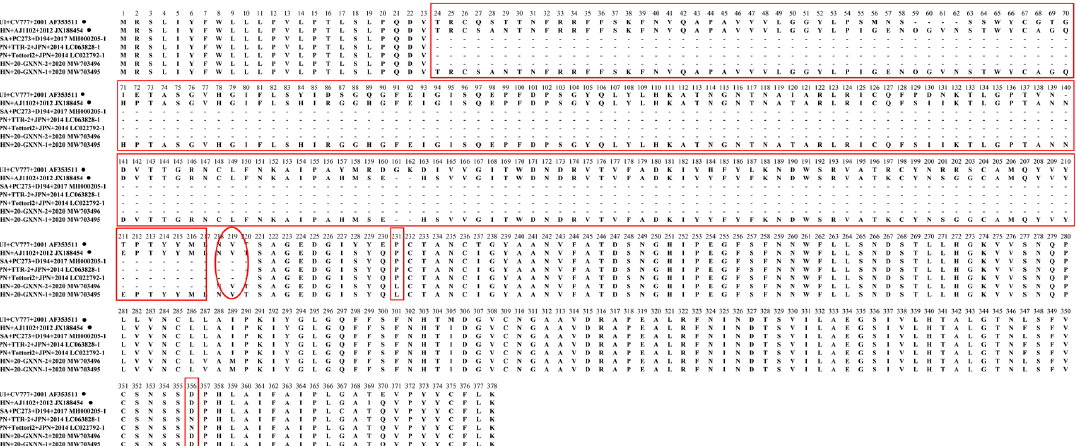
Figure 6. The alignment of amino acid sequences in the partial S1 protein of PEDVs in the Guangxi and reference strains. The deletions and mutations in the partial S1 protein of PEDV identified are shown in red boxes for the partial S1 protein.